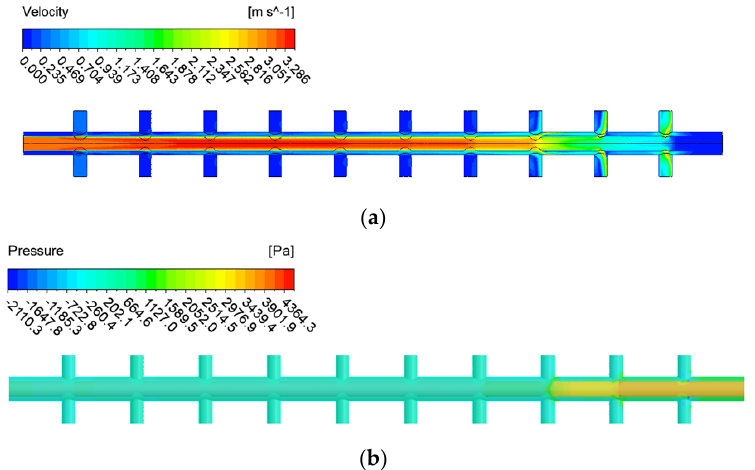
Figure 7. CFD simulation results for Case B (end closed with orifice wall): ( a ) velocity contour; ( b ) pressure distribution contour.